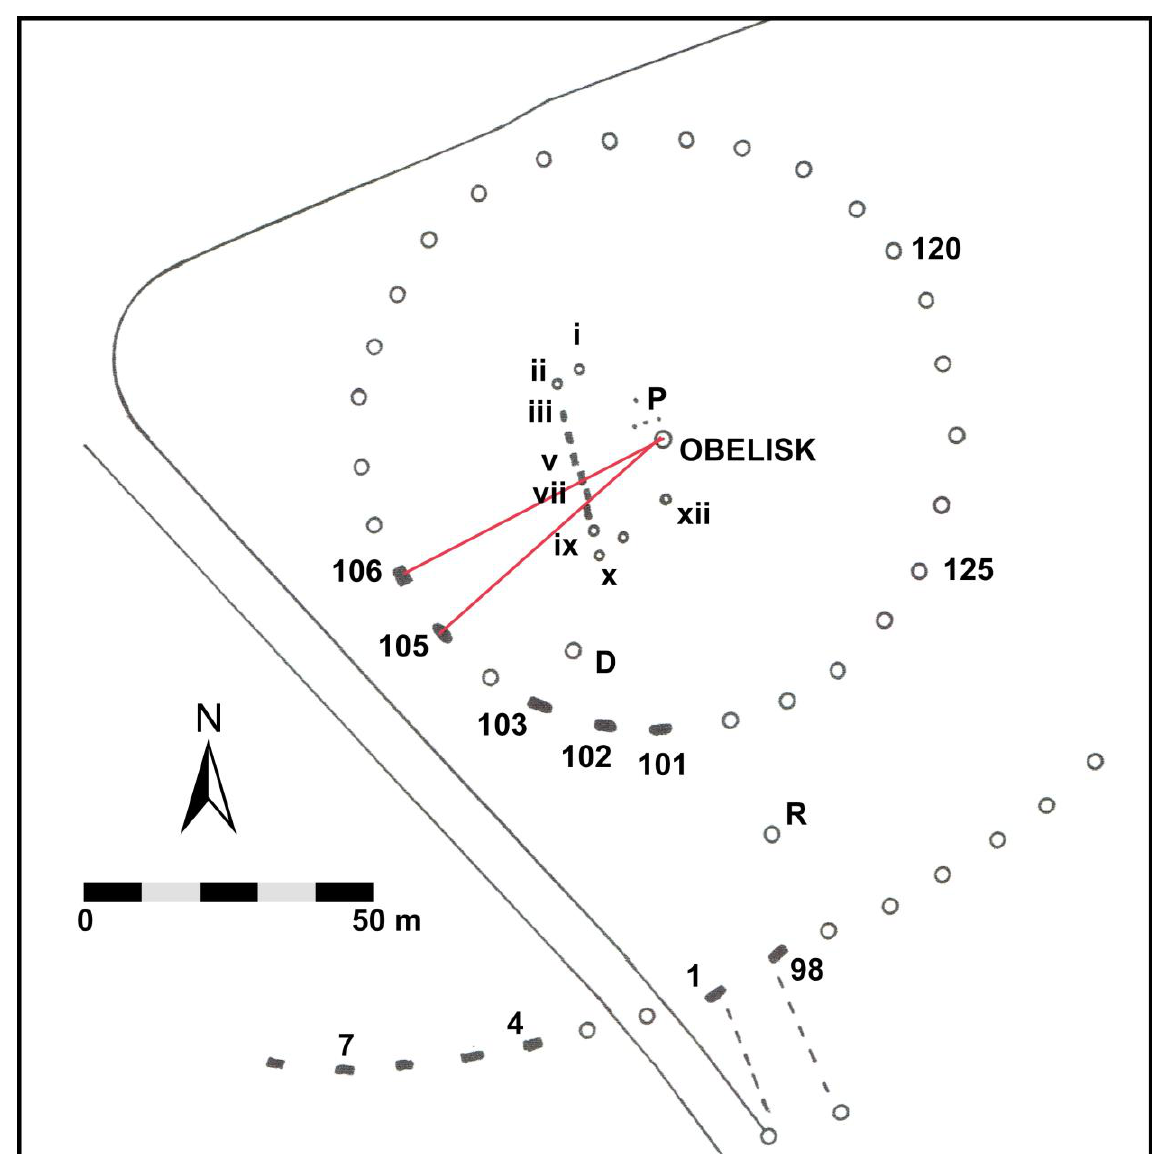
Figure 20. Plan of the South Circle at Avebury showing the relationships of Stones 106 and 105 with the directions of the Obelisk and Beltane at the summer solstice sunrises (drawn by the author after Smith 1965: